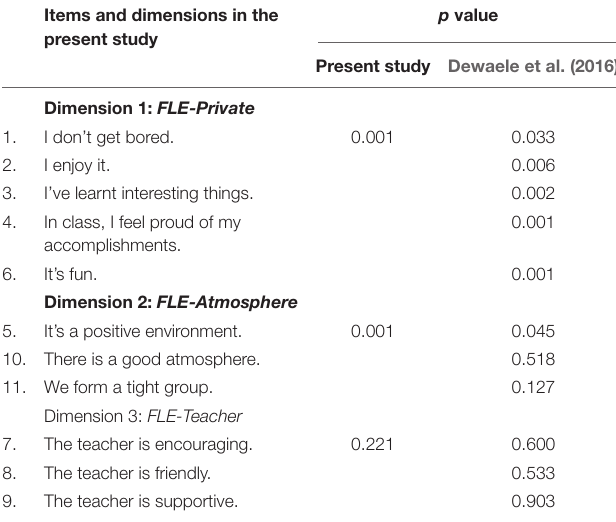
TABLE 1 | Comparison of Dewaele et al. (2016) and the present study in the effects of gender on FLE at dimension and item